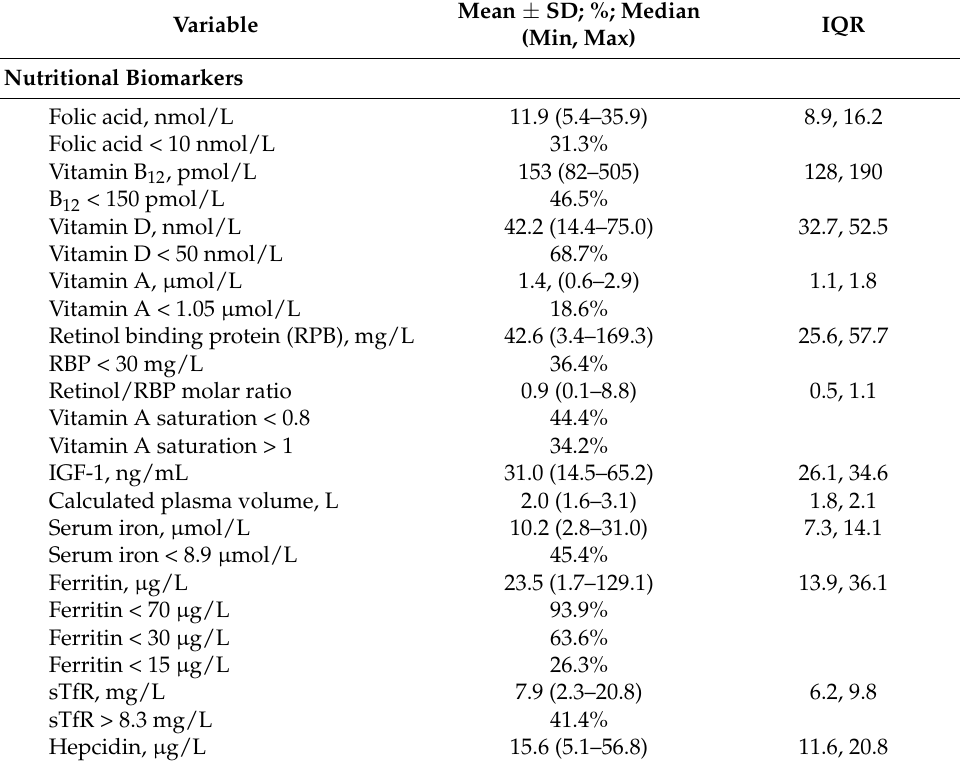
Table 2. Biochemical indicators of nutritional status, iron status, immunity, and inflammation in indigenous lactating women from